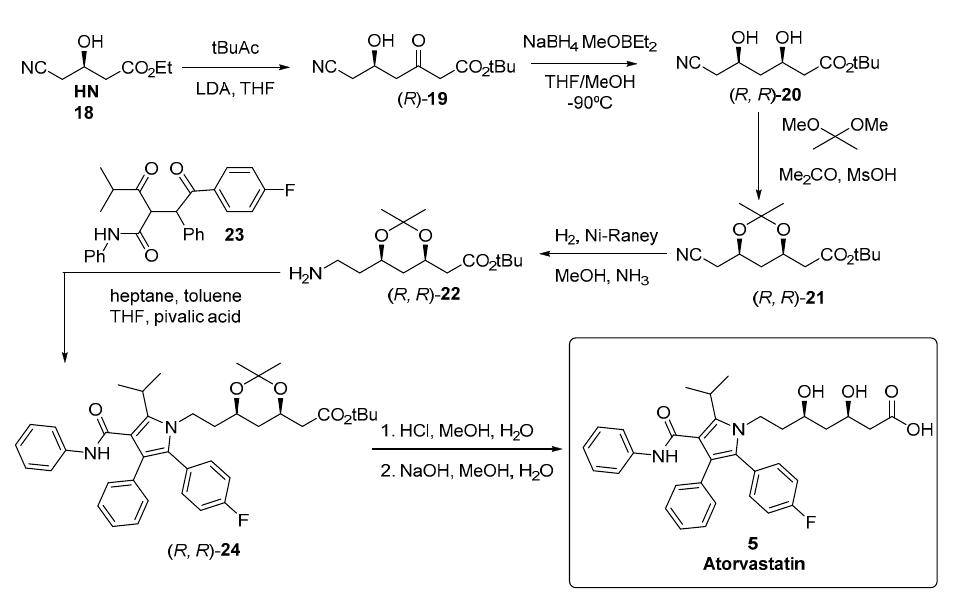
Figure 5. Chemical synthesis of atorvastatin 5 .